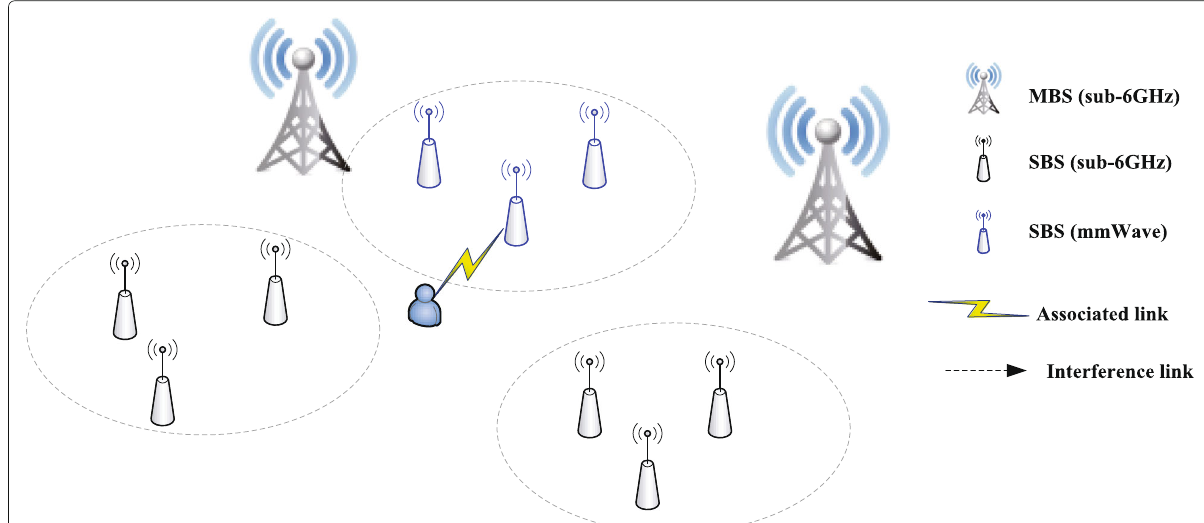
Fig. 4 The condition that UE associates with mmWave SBS